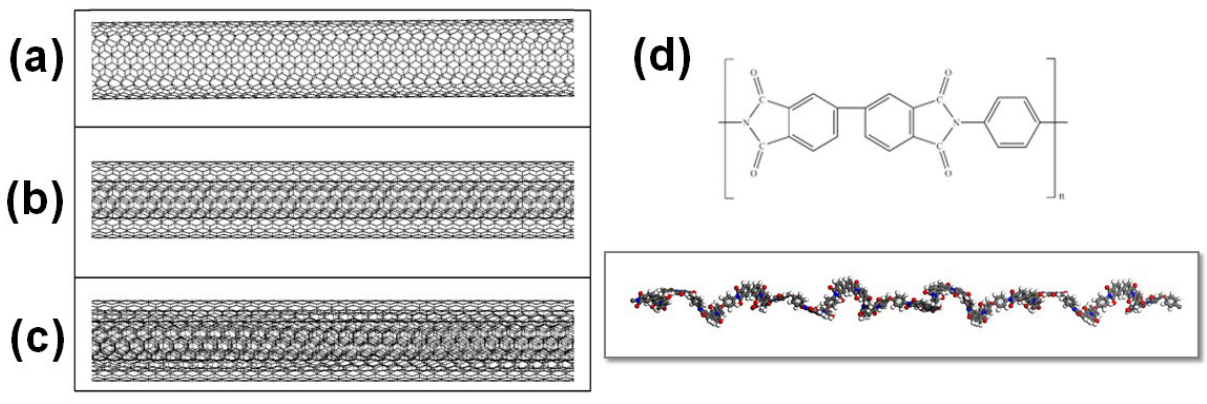
Figure 1: Molecular models of (a) SWCNT; (b) DWCNT; (c) TWCNT; (d) basic repeat unit and single chain of the BPDA/PDA